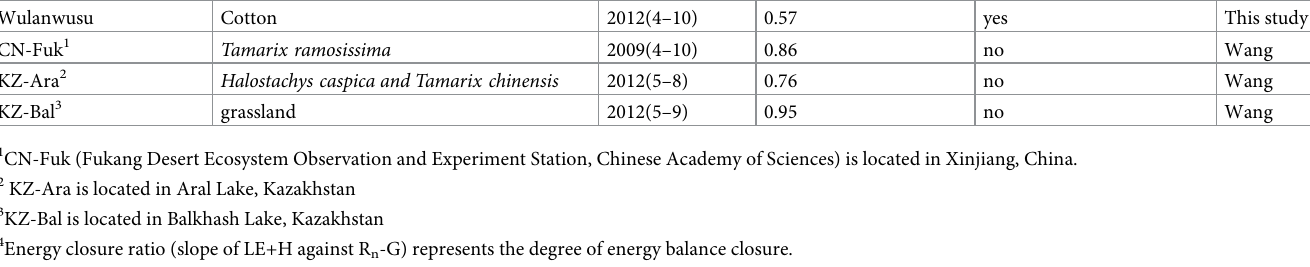
Table 4. Energy closure ratio comparsions of mulched cotton in the Wulanwusu and non-mulched vegetations in other areas. Experimental